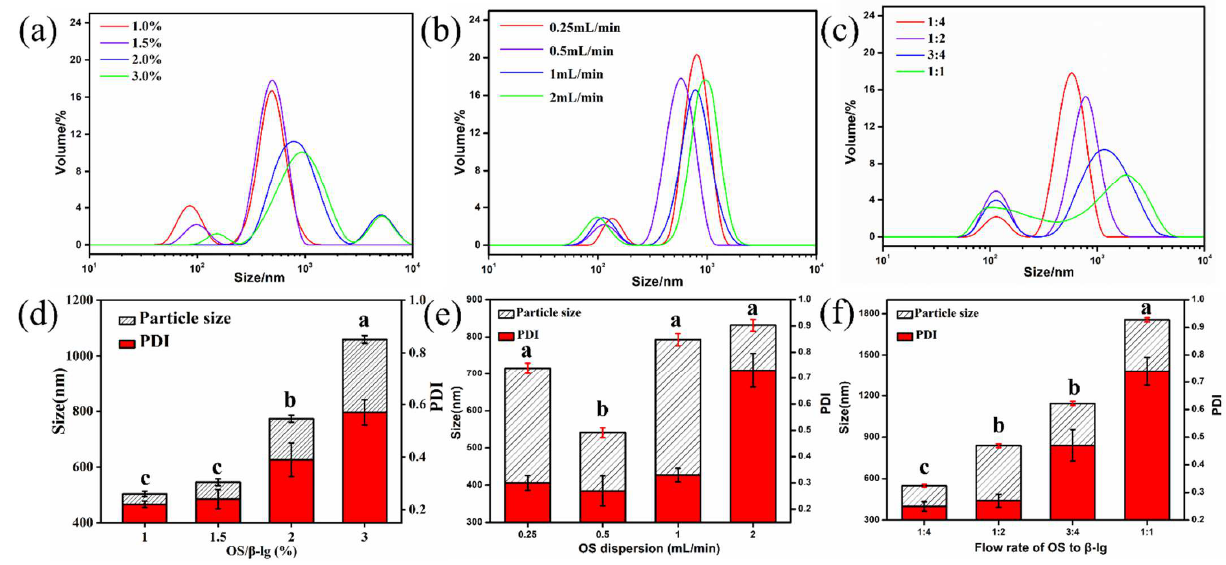
Figure 1. Particle size distribution ( a – c ), particle size, and PDI ( d – f ) of OS/β-lg complex particles at different total concentrations, flow rates of pump 1, and flow rate ratios of pump 1 to 2. Bars with different letter superscripts are significantly different at p < 0.05.